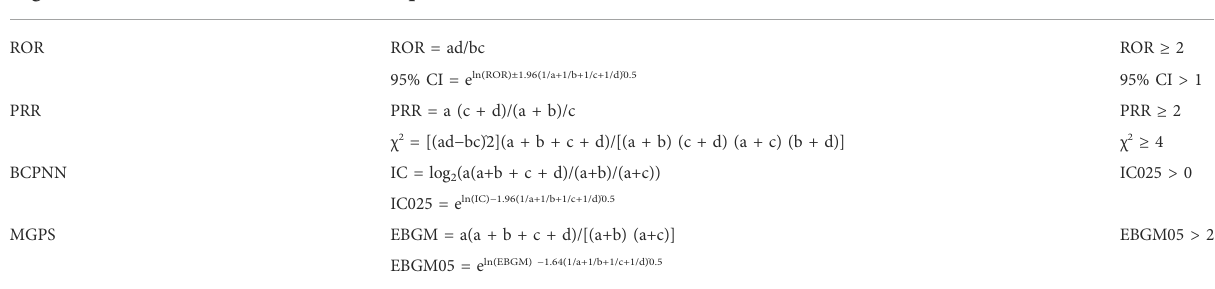
TABLE 1 Summary of four algorithms used for signals detection.